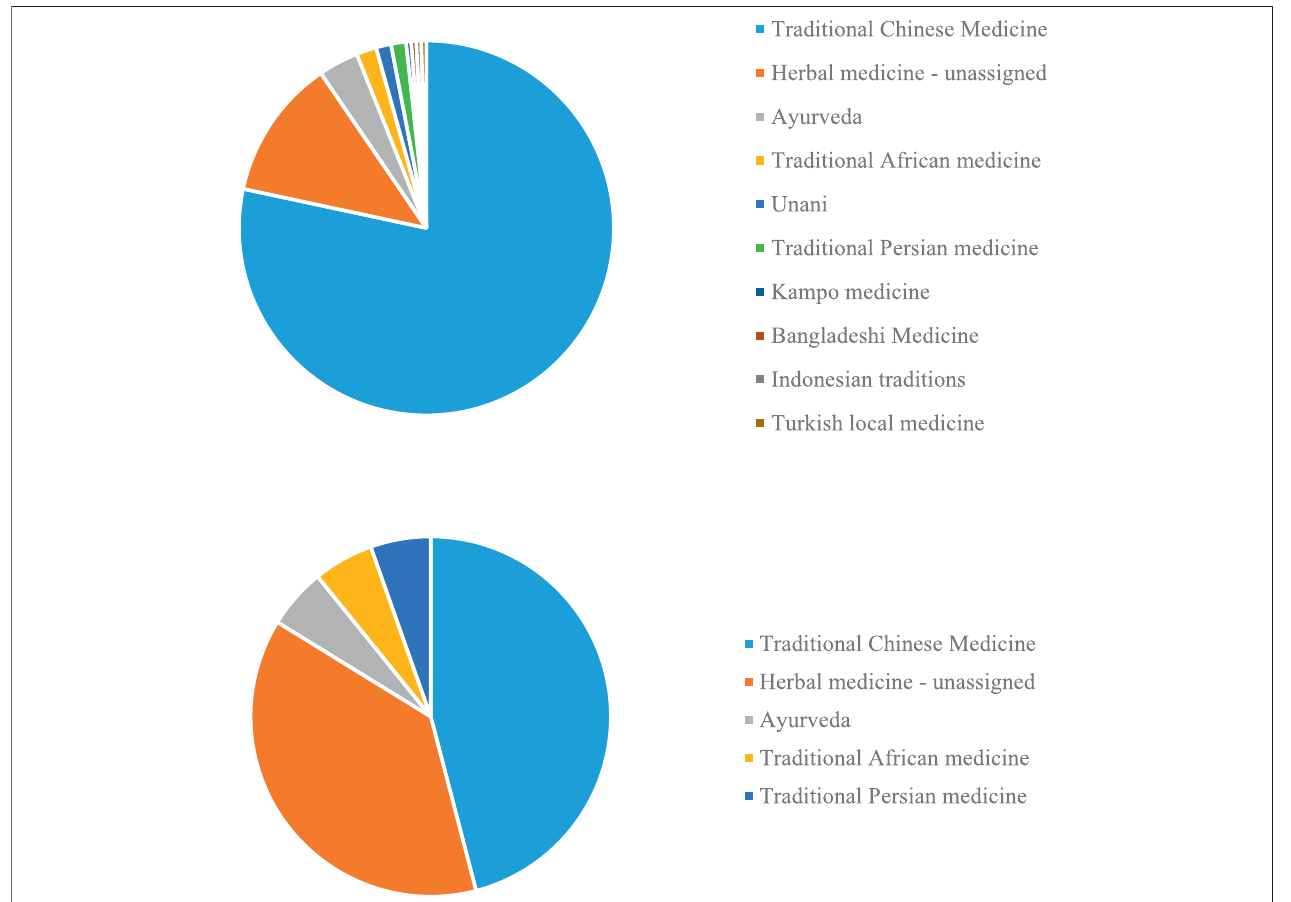
FIGURE 1 | COVID-19 papers focusing on different local and traditional medical systems (TMs) (A) in PubMed. and (B) represented in this research topic.